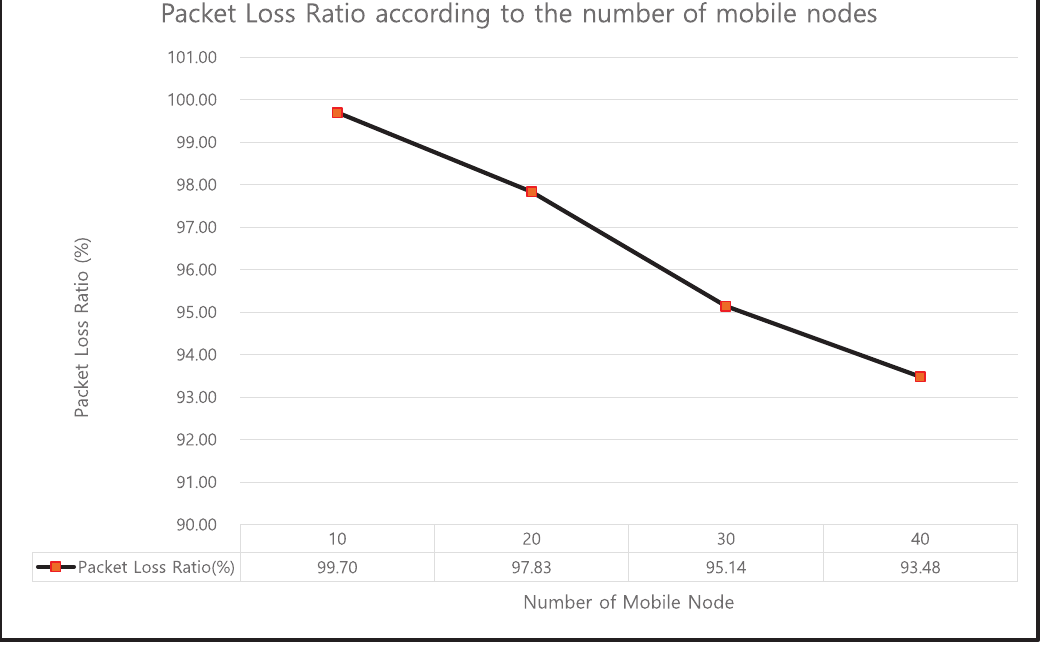
Fig 26. Packet loss ratio according to the number of mobile nodes.